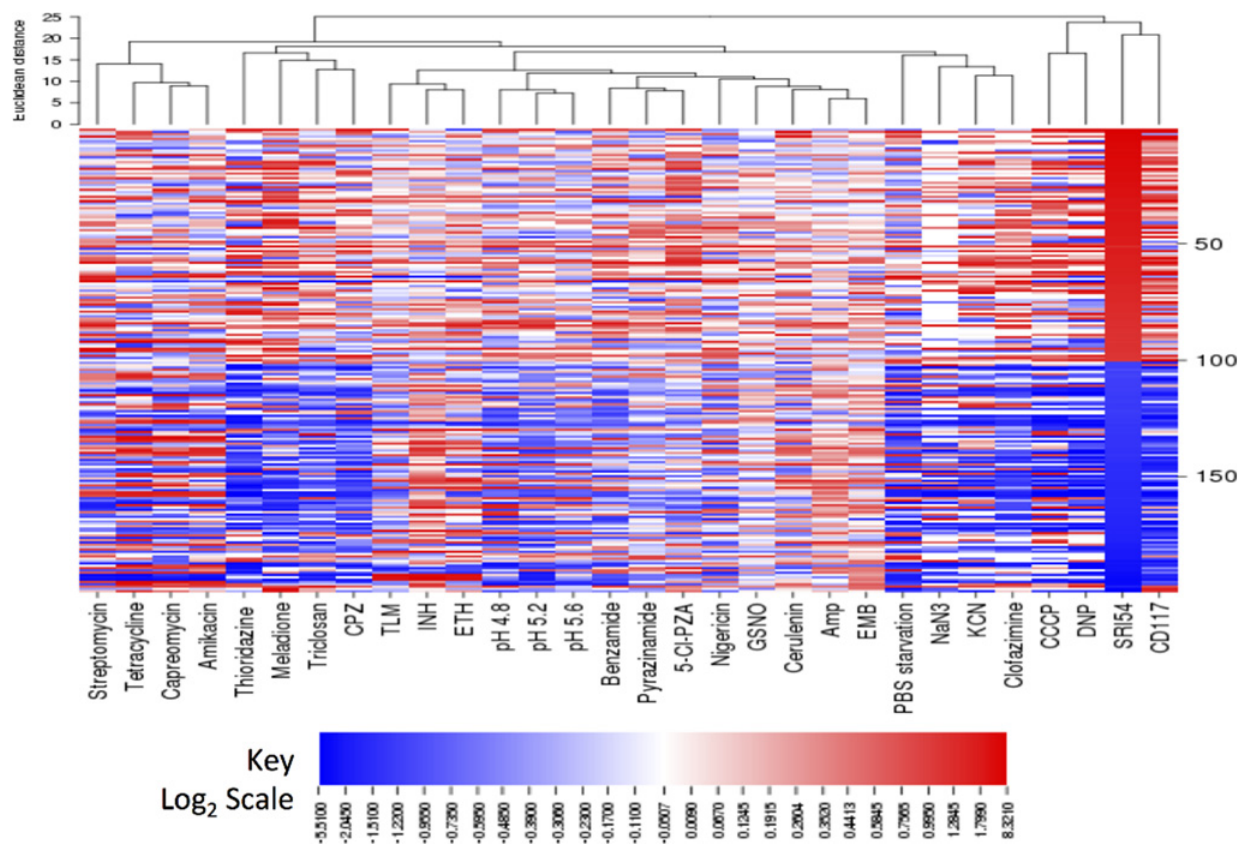
Fig 4. Mtb transcriptional response to SRI54 as compared to other small molecule antituberculars and environmental stresses. 100 SRI54 most induced and repressed genes (top-bottom) are clustered with responses to other treatments (left-right). The top dendrogram indicates relatedness of the Mtb perturbations based on gene clusters. Red indicates increase, blue indicates decrease and white no change in expression versus DMSO treatment. Amp , ampicillin; EMB , ethambutol; TLM , thiolactomycin; INH , isoniazid; ETH , ethionamide; 5-Cl-PZA , 5-chloropyrazinamide, CPZ , chlorpromazine; CCCP , carbonyl cyanide 3-chlorophenylhydrazone; GSNO , S-nitrosoglutathione; DNP ,